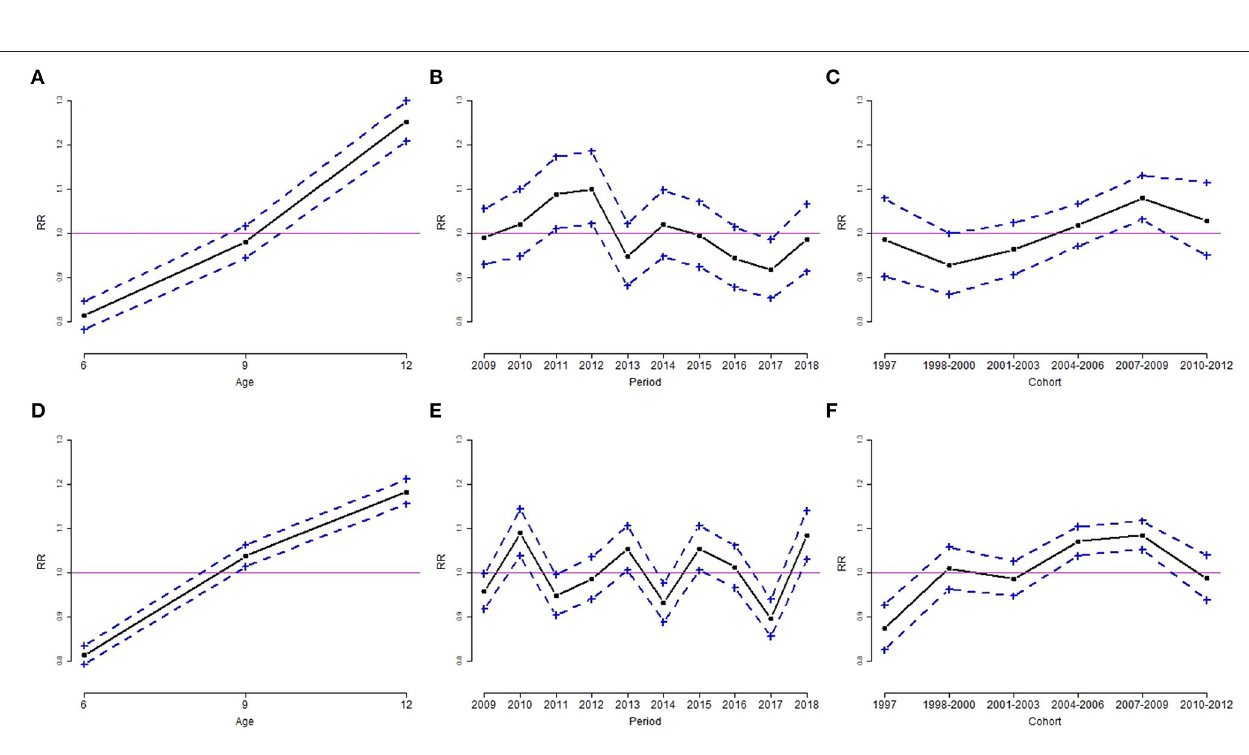
Frontiers in Pediatrics |